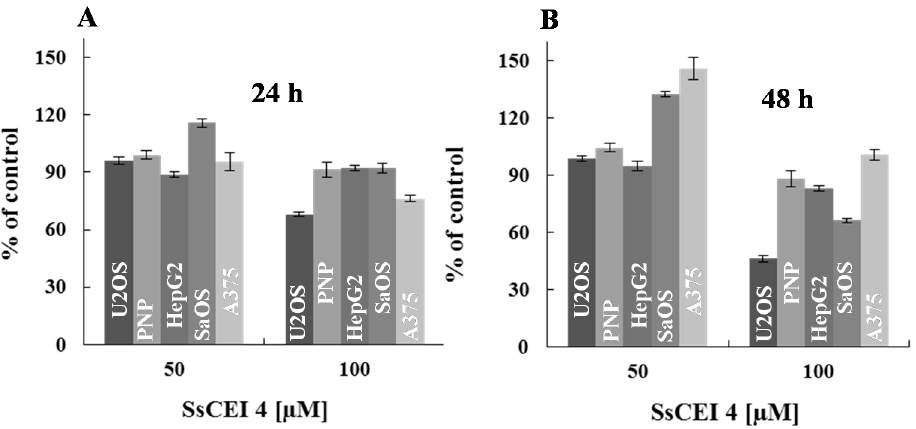
Figure 2. Human cancer cells exhibit differential sensitivity to the anti-proliferative activity of SsCEI 4. The effects of peptide on cell viability were assessed in cancer cell lines belonging to Group 1, exposed for 24 ( A ) and 48 h ( B ) to increasing concentrations of SsCEI 4. Data are normalized to the values obtained with the untreated cells and are expressed as means ± SD values of triplicate data from three independent experiments.